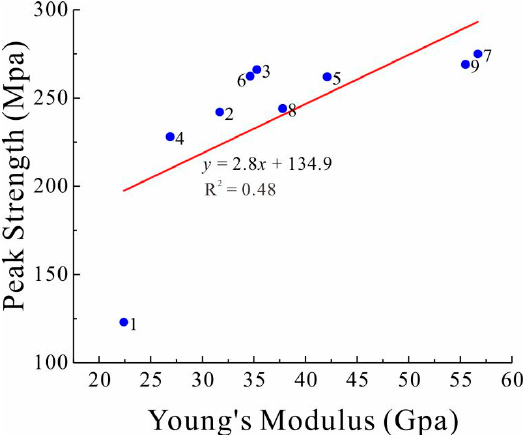
Figure 7. The relationship between Young’s modulus and peak strength.